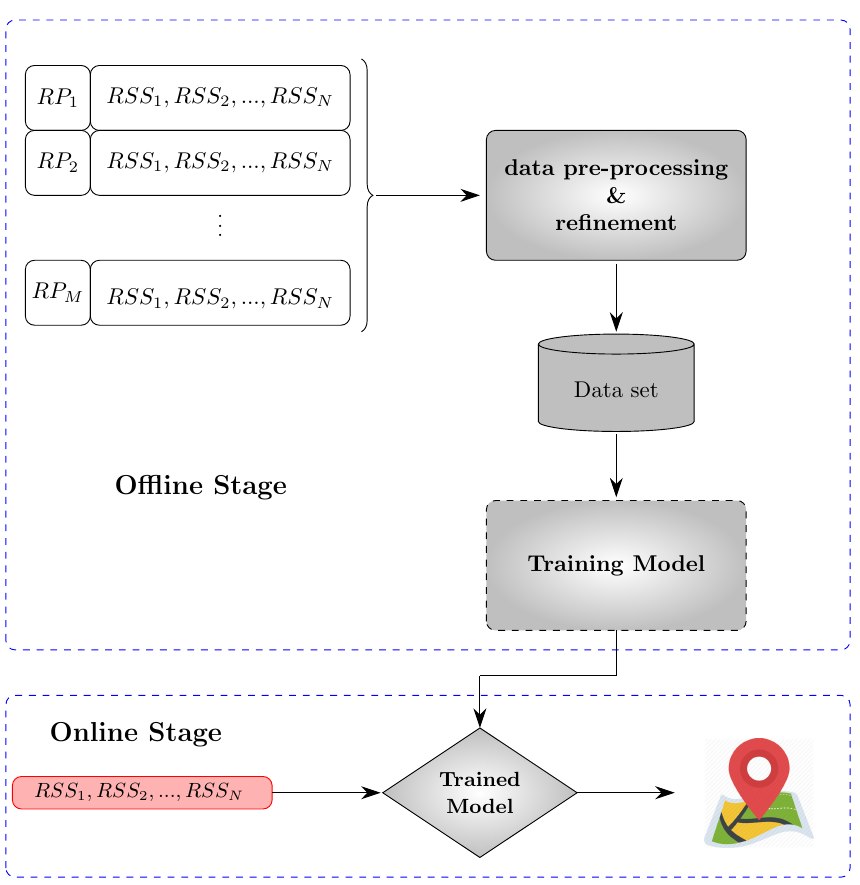
Figure 6. Fingerprinting block